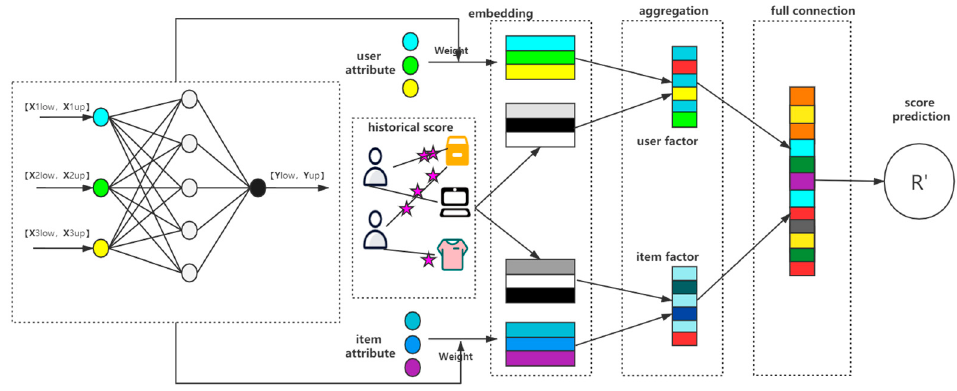
Figure 3. The overall architecture of the proposed model.